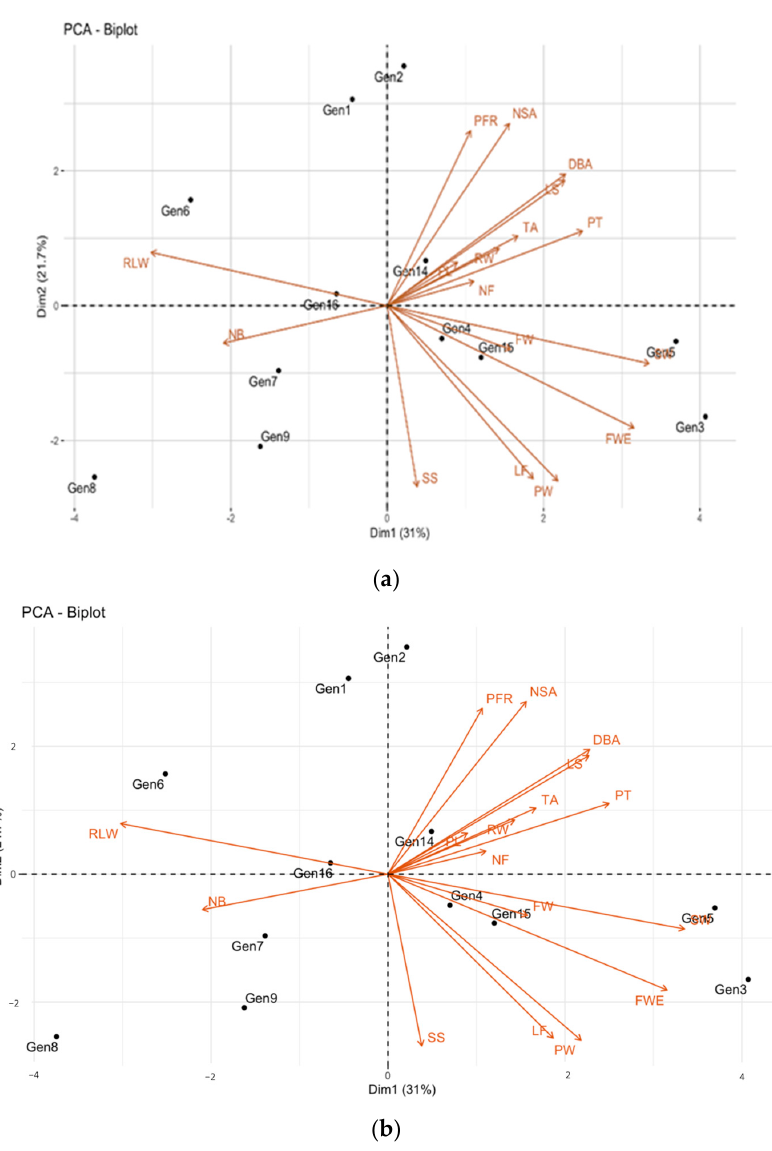
Figure 3. Principal component analysis of the quantitative variables of the yellow pitahaya genotypes: ( a ) open-field system and ( b ) under cover. Number of fruits (NF), length of the phylloclade (LF), distance between areolas (DBA), number of spines per areola (NSA), width of the ribs (RW), length of the largest spine (LS), length of the fruit (LF), fruit width (FW), length/width ratio (RLW), fruit weight (FWE), peel weight (SW), pulp weight (PW), pericarp thickness (PT), peel/pulp ratio (PFR), number of bracts (NB), soluble solids (SS), and titratable acidity (TA). The analysis of the principal components for the quantitative variables of morphoagronomic nature in the covered system showed that the total variance was expressed in two (2) principal components with an accumulated value of 52.7%, where the first component grouped most of the analyzed variables. Large, negative associations were observed with fruit weight (PF), peel weight (SW), pulp weight (PW), and fruit length (LF). Genotypes 3 and 5 showed negative associations with CP1. The second principal component (CP2) only associated two variables: the length/width ratio (RLW) (positive association) and the number of bracts (NB) (Figure 3b).